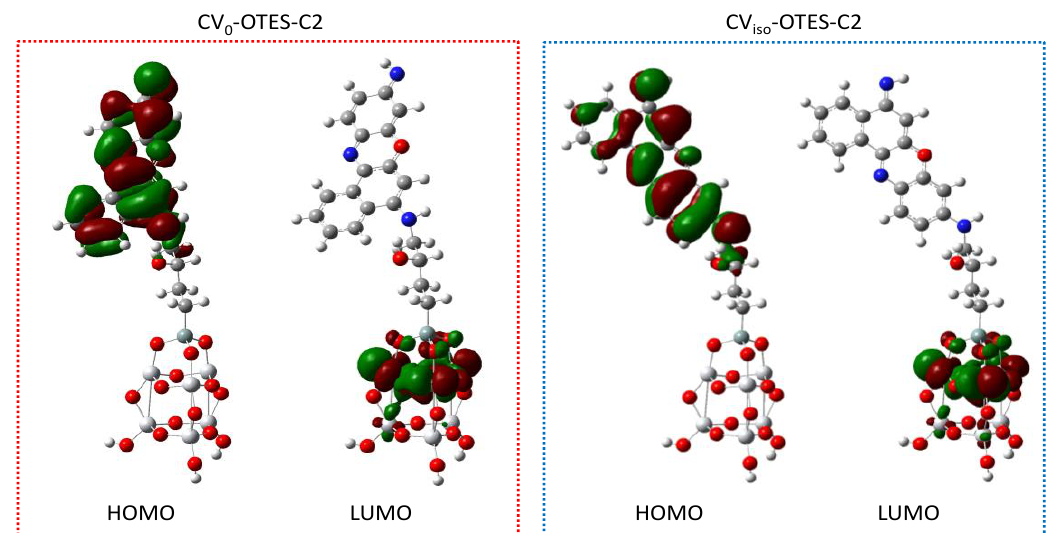
Figure 8. HOMOs and LUMOs of CV 0 –OTES–C2 or CV iso –OTES–C2 adsorbed on the TiO 2 cluster using CPCM in EtOH, calculated at the B3LYP/6-31G*/LanL2DZ level of theory. Surface isovalue: 0.02 e/bohr 3 .